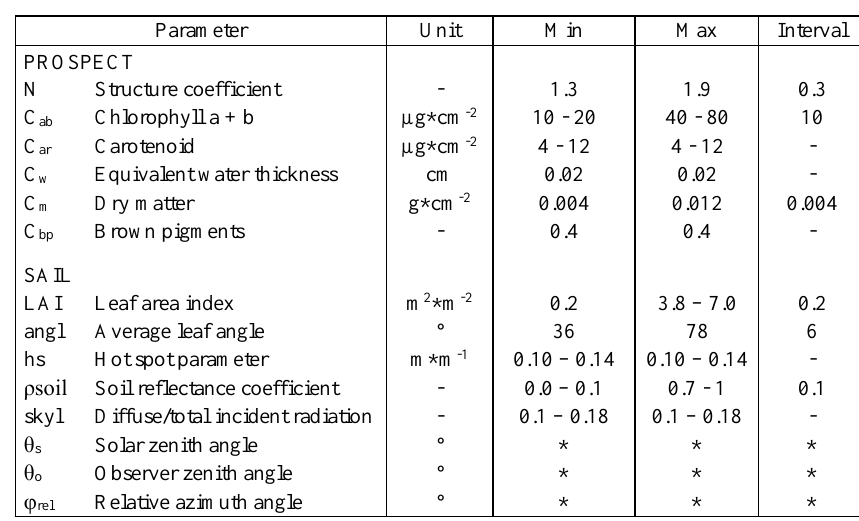
Table 2: PROSAIL parameter settings for the 2011 RapidEye scenes. For each parameter, the minimum, maximum, and sampling interval is given. For the parameters whose upper and lower boundaries varied throughout the year, the respective highest and lowest minimum and maximum boundary values used are given. If a parameter was fixed to a certain value, no interval is indicated. The sun and sensor zenith and azimuth angles (*) were calculated for each pixel based on the scene specific sun and sensor angles as well as on an SRTM DEM, grouped into classes for the reflectance modelling, and fixed during